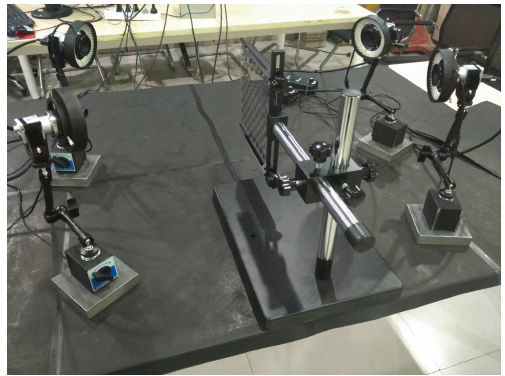
Figure 9. The four-camera system.